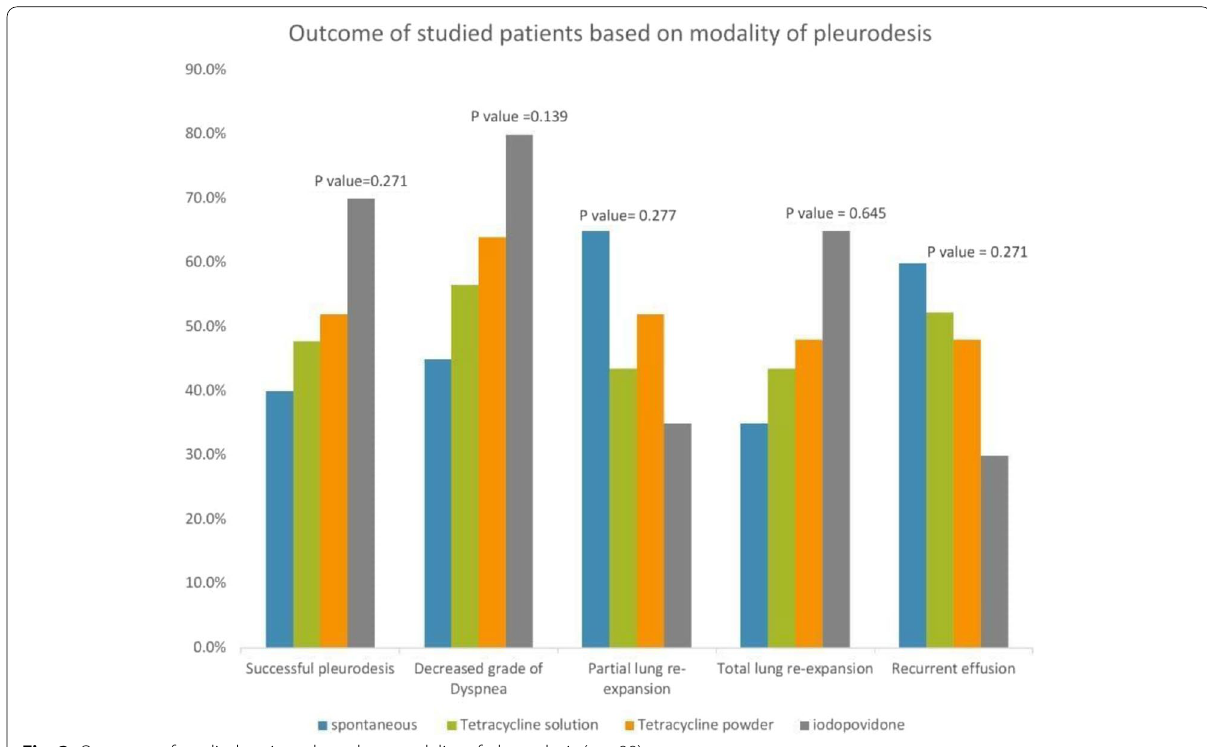
Fig. 3 Outcome of studied patients based on modality of pleurodesis ( n